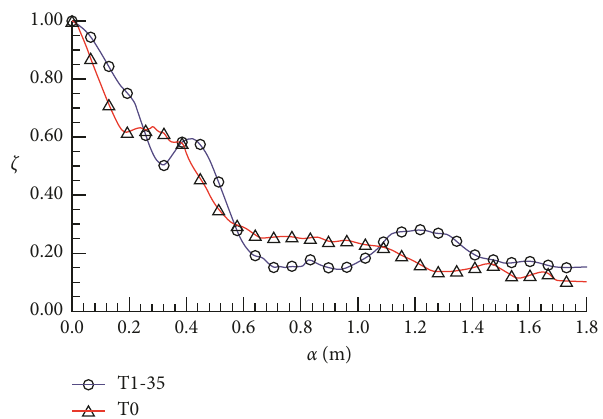
Figure 12: Variation of dissipation rate on L 1 of the single pile test.